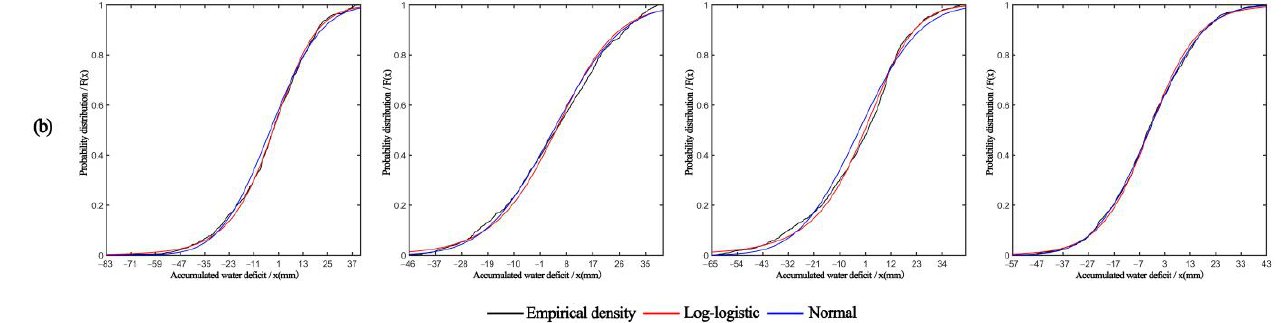
Figure 2. Comparison of three function fitting curves of crop water deficit sequence: ( a ) density curves and ( b ) distribution curve.